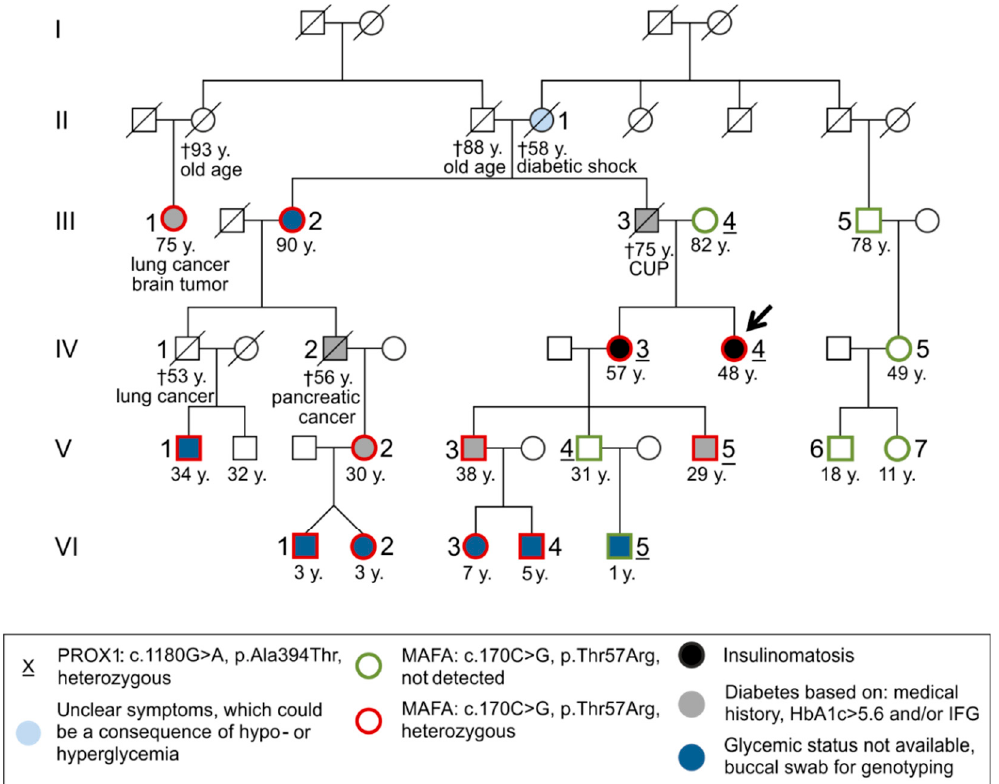
Figure 1. Pedigree, presenting genotype, phenotype and age of the family members. Four generations of the family underwent further molecular genetic ( MAFA Thr57Arg and PROX1 Ala394Thr; genotyped individuals marked by the bold border of the symbols) and laboratory testing as well as an evaluation of the medical history. In individuals with the symbol filled in dark blue, only a buccal swab was available for laboratory analysis (III2, V1, and VI1–5), suitable for genotyping but not for metabolic analyses, e.g., the determination of HbA1c. MAFA Thr57Arg was detected (symbols with red bold border) in 12 family members (III1–2, IV3–4, V1–3, V5, and VI1–4), 2 with insulinomatosis (IV3–4, arrow points on index case), 4 with an overt diabetes (III1 (based on patient medical history), V2–3 and V5 (HbA1c > 5.6 or impaired fasting glucose (IFG)), and 6 members (4 children below 10 years (VI1–4) and 2 adults (III2 and V1)) whose glycemic status was unclear, because blood samples were not available. Furthermore, diabetes mellitus was known in 2 deceased individuals (III3 and IV2). In 7 family members who did not carry Thr57Arg (symbols with green bold border), neither diabetes nor insulinomatosis has been detected (III4–5, IV5, and V4 + 6–7) or they had an unclear glycemic status (VI5). Subject numbers of the six PROX1 Ala394Thr carriers are underlined (III4, IV3–4, V4–5, and VI5). The MAFA mutation is inherited through the left wing of the pedigree (starting with the left couple in generation I). The PROX1 variant, on the other hand, was introduced into the pedigree by person III4 and is, thus, inherited only throughout one branch. CUP = cancer of unknown primary; y. = age in years; † = deceased.